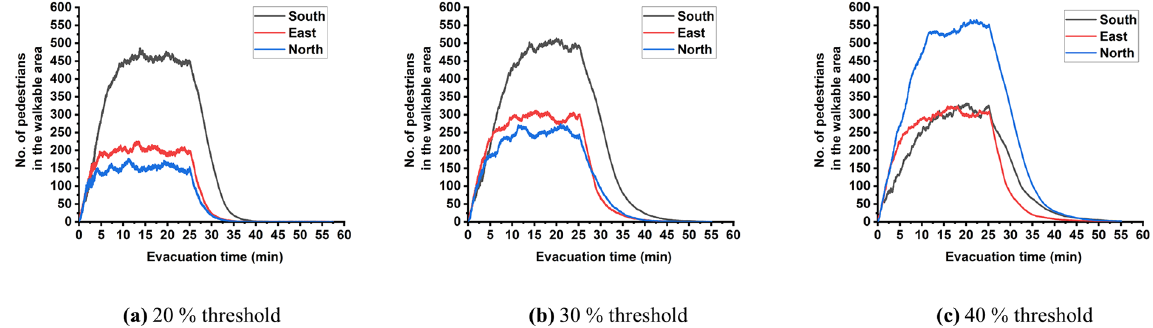
Figure 12. Total number of evacuating pedestrians in the walkable area plotted according to their destination choices for the south, east and north during the evacuation time: (a) 20% threshold, (b) 30% threshold, and (c) 40%